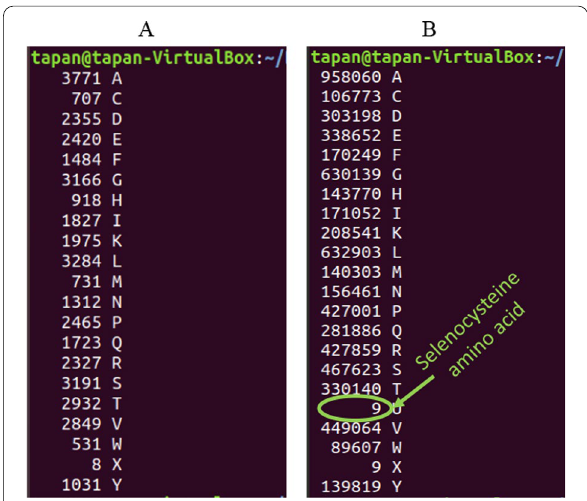
Fig. 1 A Amino acid composition of fungal protein sequences annotated with the term selenoprotein/selenocysteine. No selenocysteine amino acids were detected in any of the protein sequences annotated as selenocysteine/selenoprotein. B Amino acid composition of the Chlamydomonas reinhardtii proteome revealing the presence of Sec (U) amino acids. The whole proteome of C. reinhardtii was used as a reference to demonstrate the presence of U amino